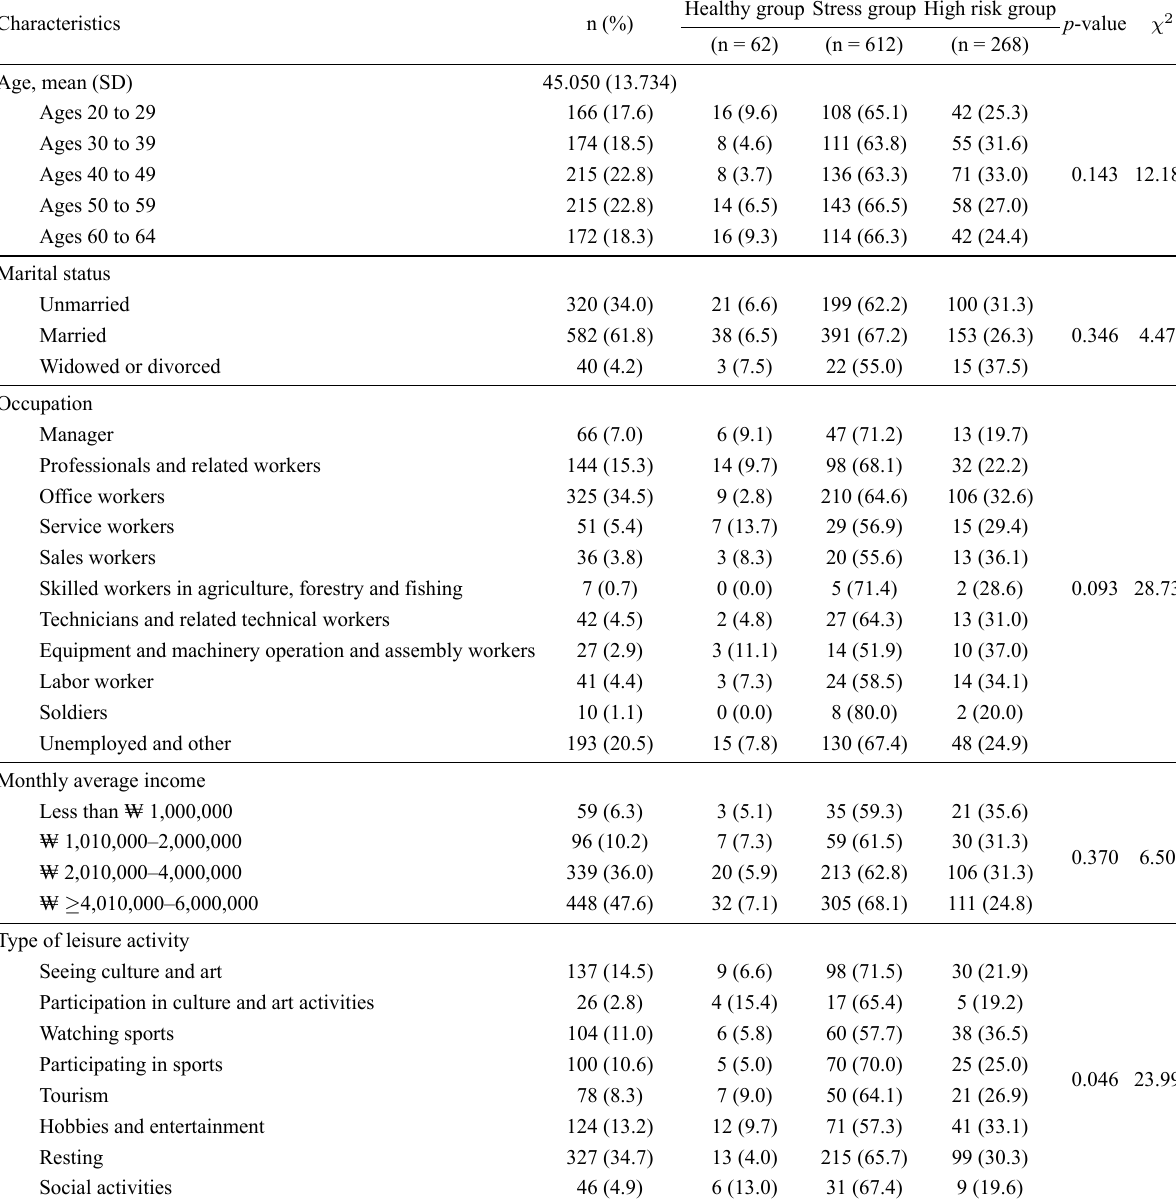
Table 2. Demographic characteristics of participants (n =